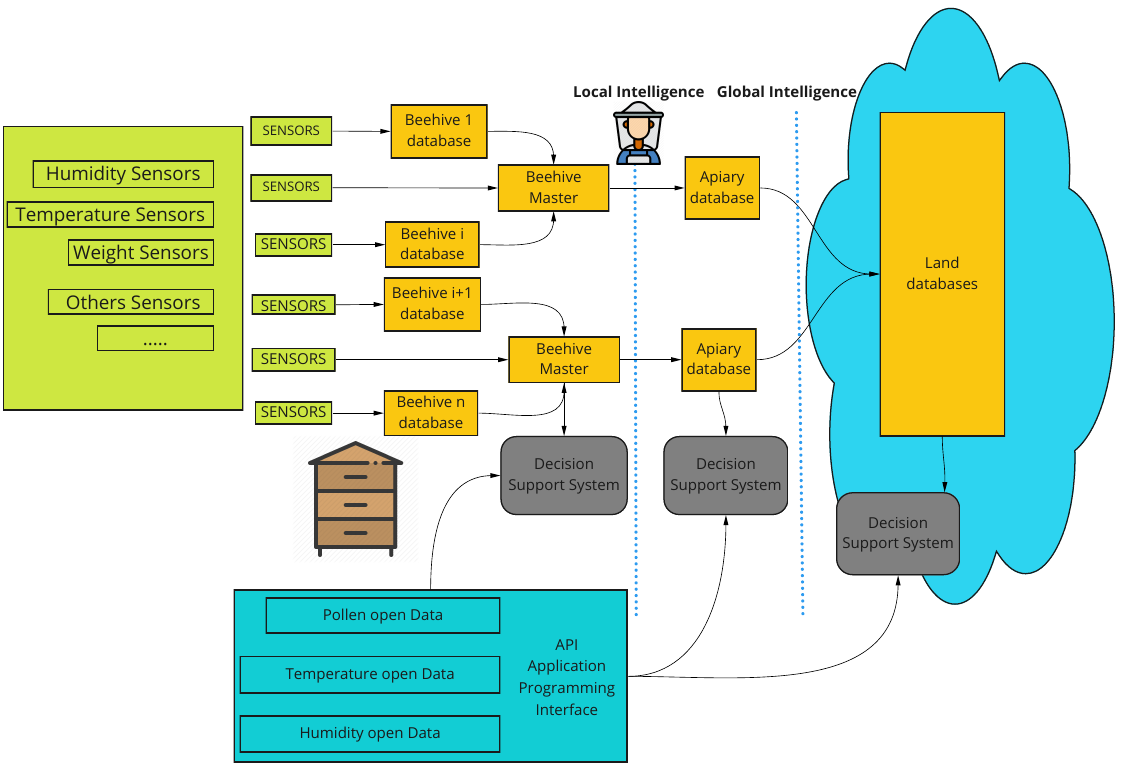
Figure 4. Global view of the decision support systems for smart